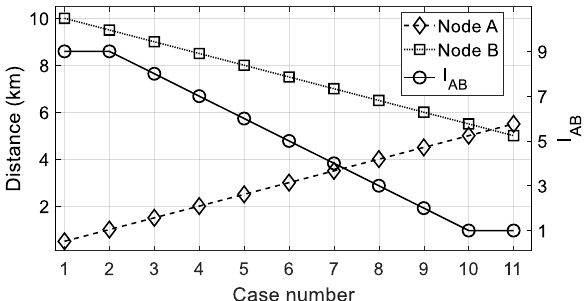
Figure 5. Importance value I AB (circles) when nodes A and B are compared under the distance criterion. Data: d max = 10 km, d min = 0.5 km, δ =